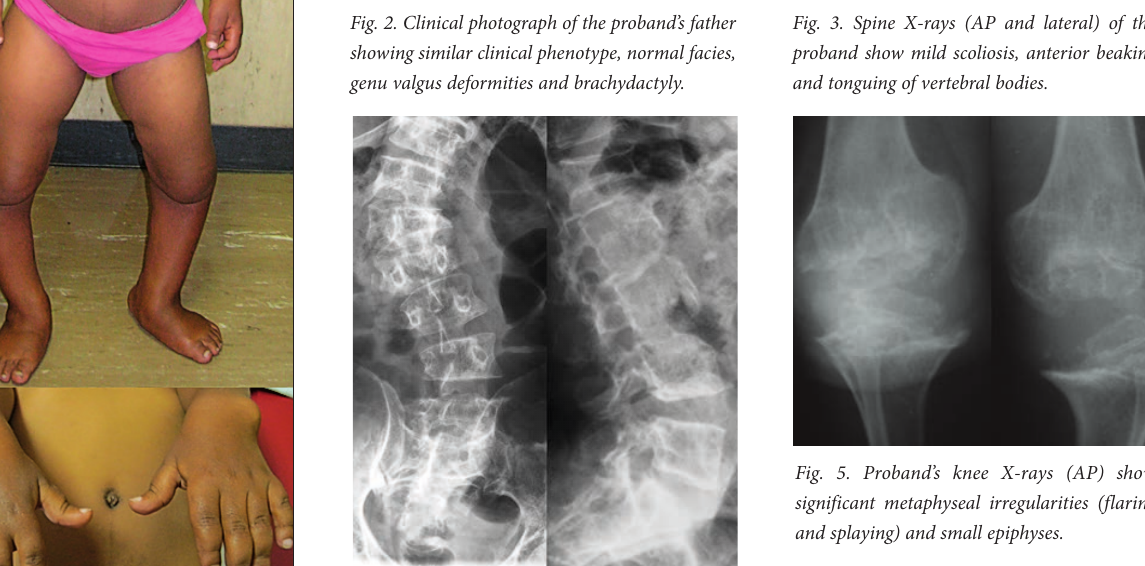
Fig. 4. Spine X-rays (AP and lateral) of the proband’s father show marked scoliosis, degenerative changes, platyspondyly (probably secondary to compression fractures) and less beaking and tonguing of anterior vertebral bodies than in the proband.